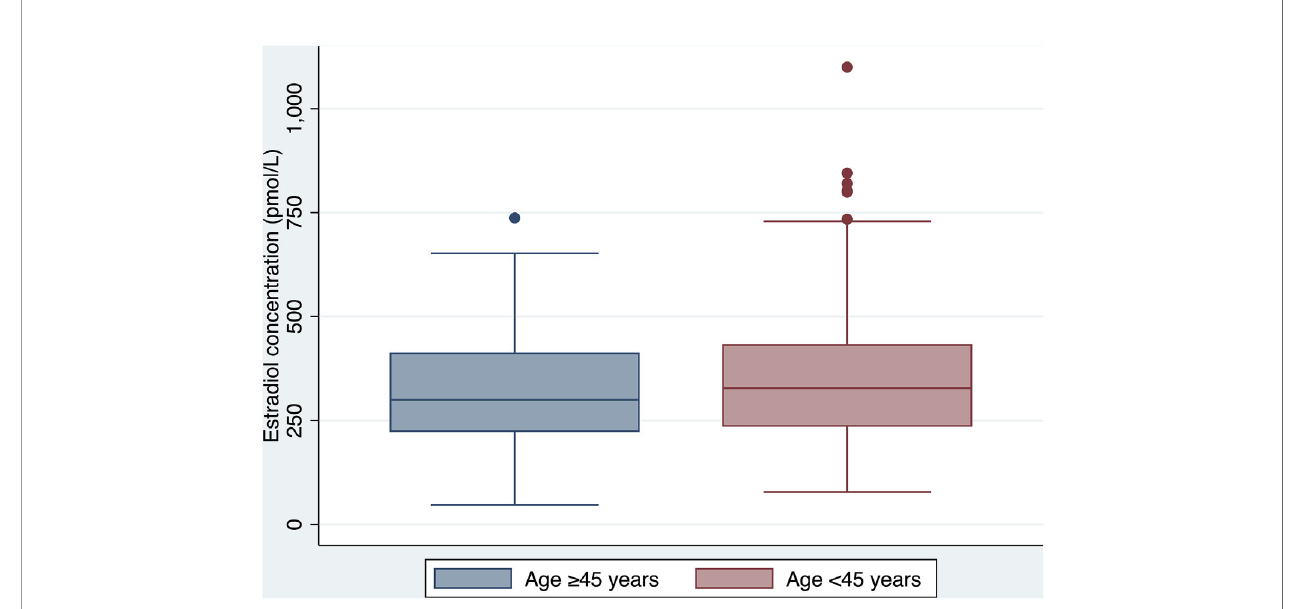
FIGURE 2 | Serum estradiol concentration by age group ( ≥ 45 vs <45